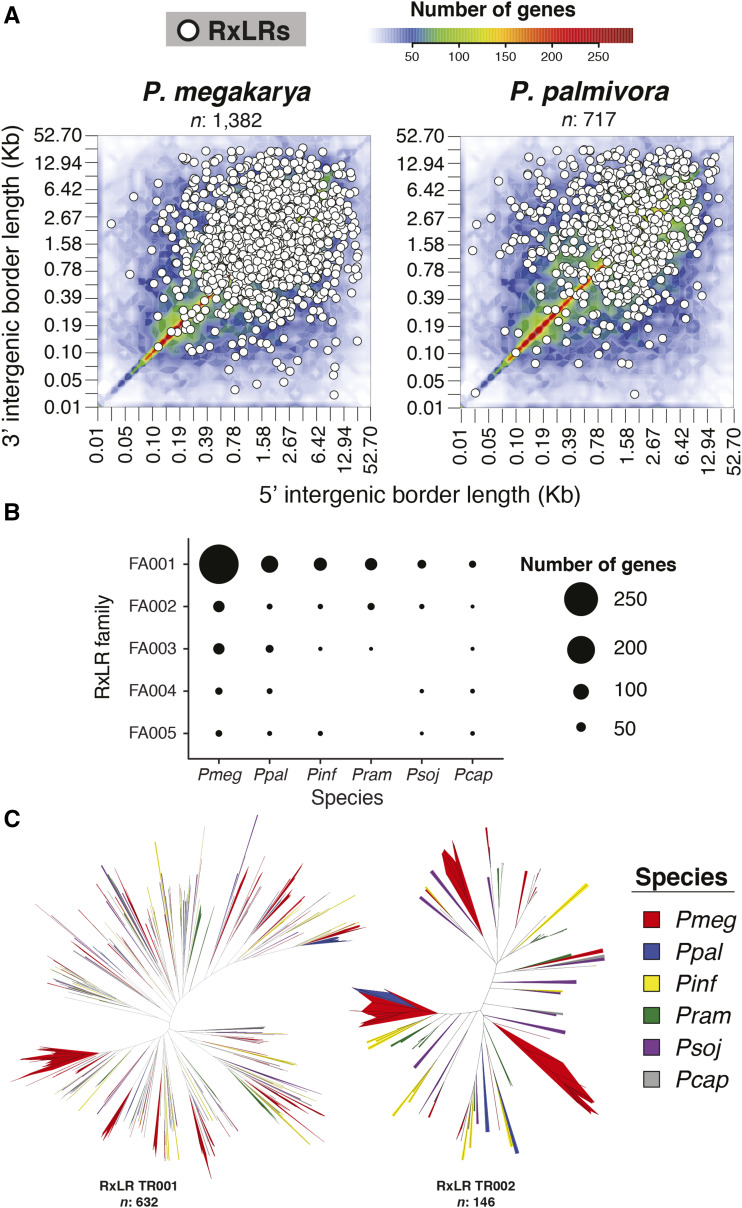
(A) Intergenic space heatmap of P. megakarya and P. palmivora with an overlayed relative position of the predicted RxLR effectors. (B) Numbers of genes in the top five RxLR families per species. (C) Phylogenetic analysis created by resampling the site likelihoods 1,000 times of the two largest families across multiple species of Phytophthora showing a clear branch-specific amplification pattern in P. megakarya. Pinf: P. infestans, Pmeg: P. megakarya, Ppal: P. palmivora, Psoj: P. sojae, Pram: P. ramorum and Pcap: P. capsici.